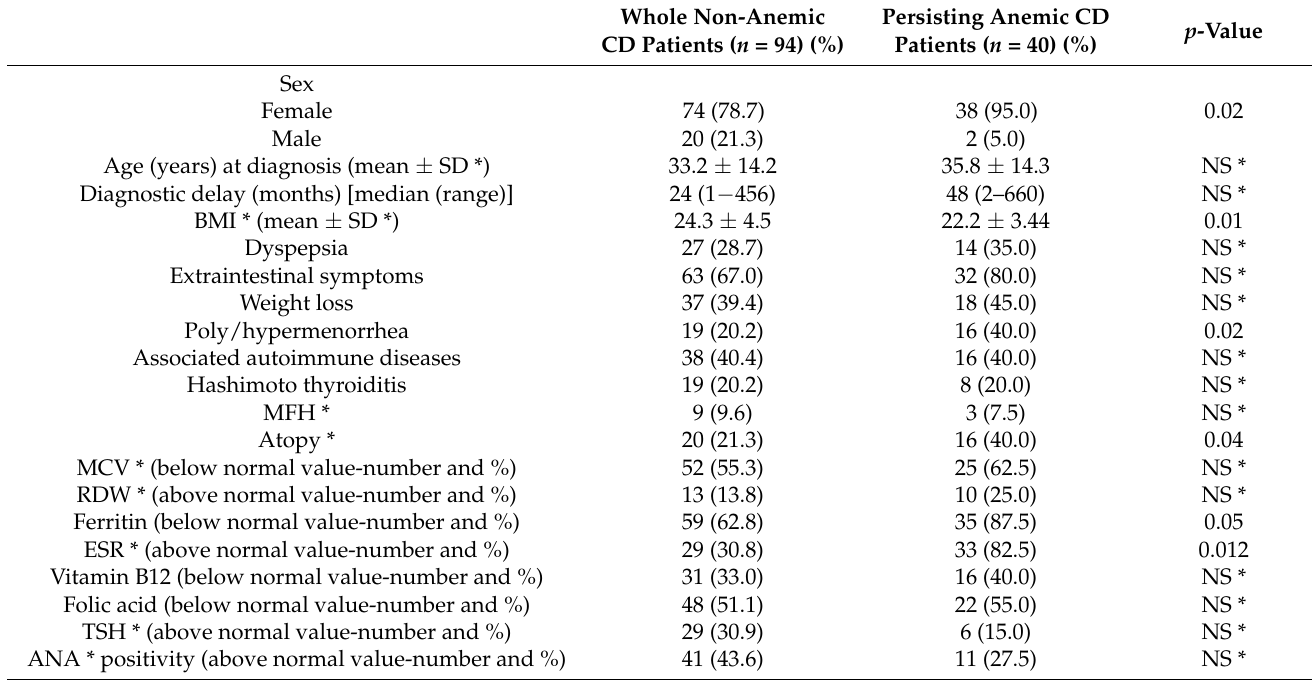
Table 3. Pre-GFD demographic, clinical, and hematochemical features of patients with persistent anemia after one year of “strict” GFD compared to the whole non-anemic ones (non-anemic before GFD plus non-anemic after